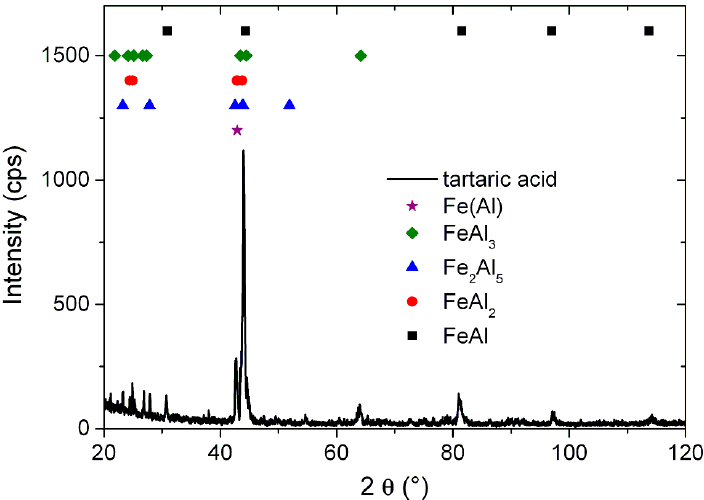
Figure 3. XRD pattern of the sample in Figure 2.